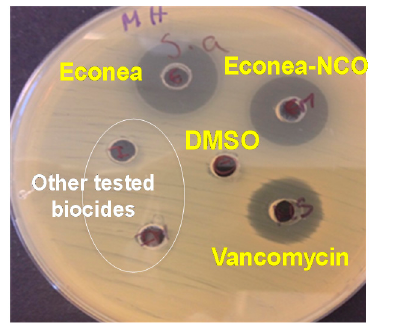
Figure 2. Representative well diffusion test for the assessment of the antimicrobial activity of Econea biocide and its functional counterpart (Econea-NCO), against Staphylococcus aureus . Dimethyl sulfoxide (DMSO) was used as the negative control and Vancomycin as the positive control. Table 2. Antimicrobial activity of the Econea biocide and its functionalised counterpart against Gram-positive bacteria. Enterococcus faecalis Biocides (mm)